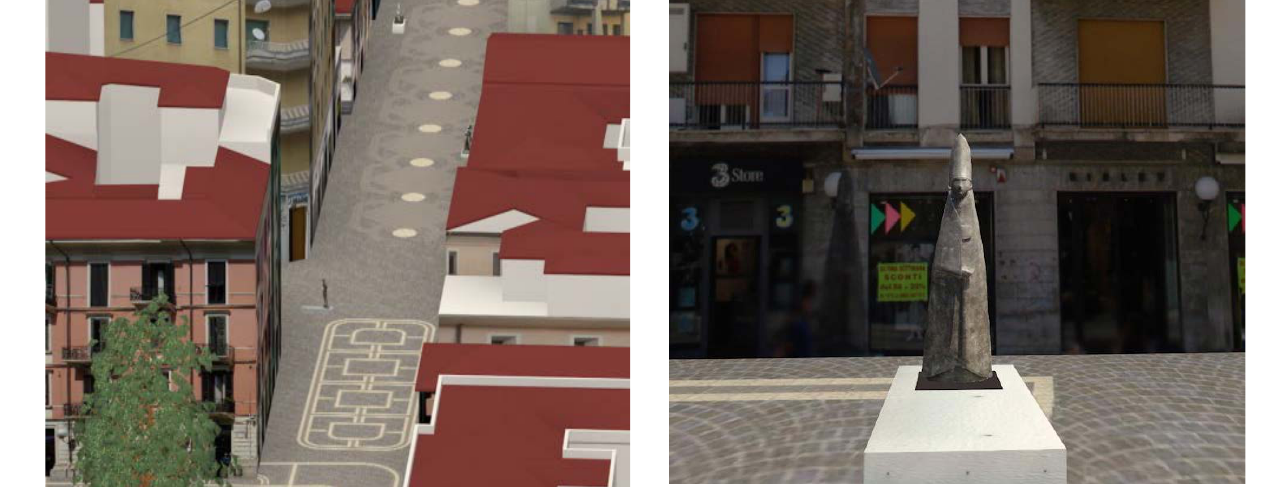
Figure 16. The model of The great Cardinal standing in the present position.